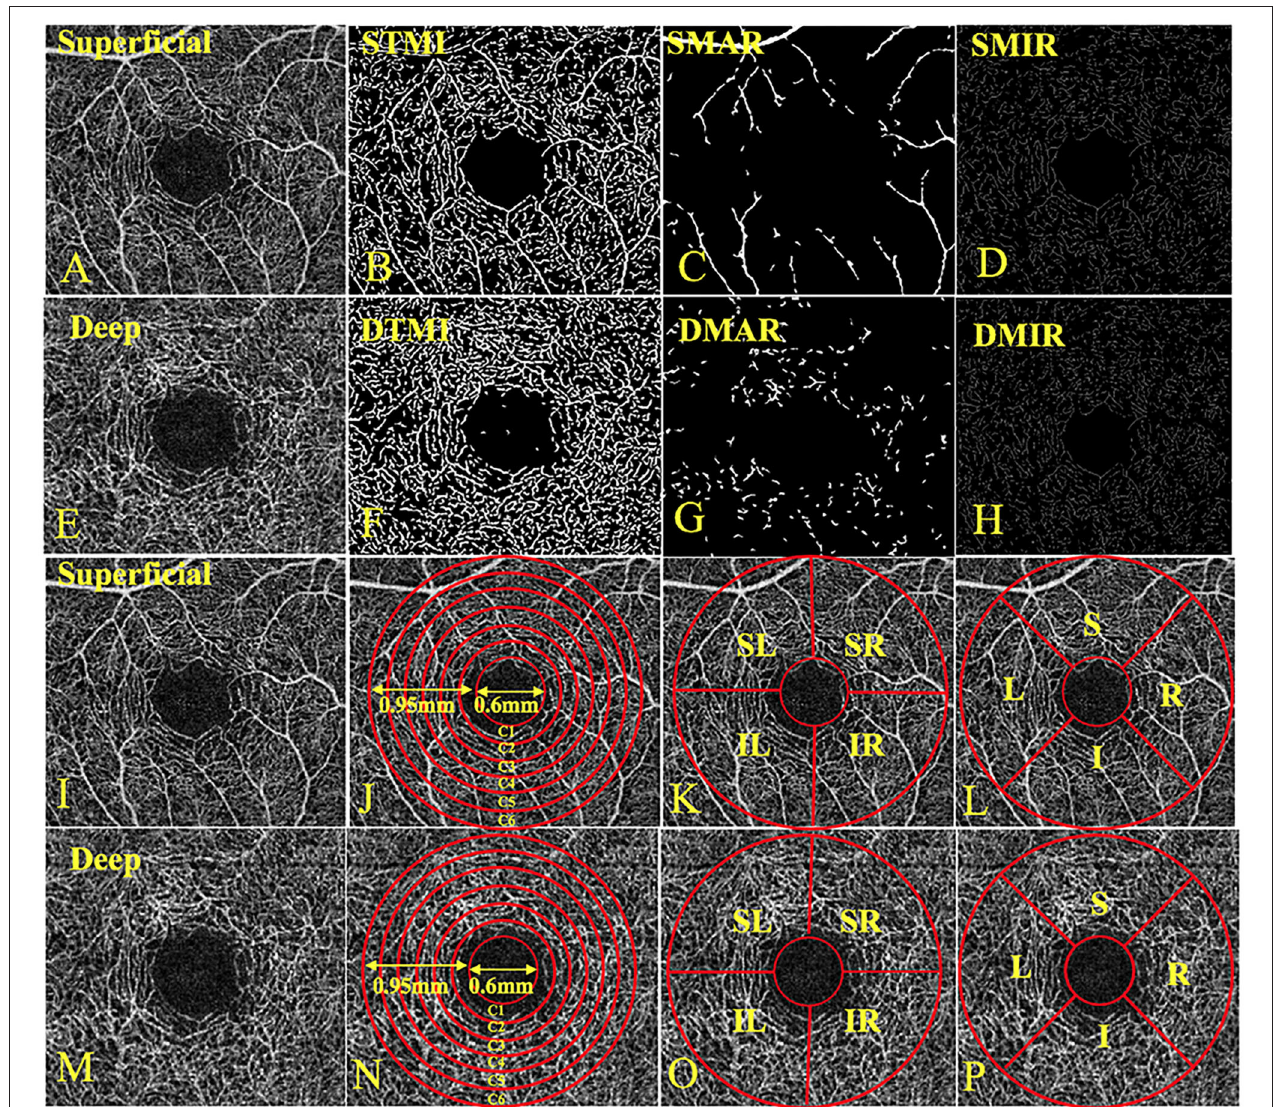
FIGURE 1 | The 3 × 3-mm OCTA image of the retina and three division methods. (A) Superficial retinal vessel density map; (B) STMI, Superficial total microvascular; (C) SMAR, Superficial macrovascular; (D) SMIR, Superficial microvascular; (E) Deep retinal vessel density map; (F) DTMI, Deeper total microvascular; (G) DMAR, Deeper macrovascular; (H) DMIR, Deep microvascular; (I) Superficial retinal vessel density map; (J) Central annuli segmentation method in superficial retina layer; (K) Hemisphere segmentation method in superficial retina layer; (L) Early treatment of diabetic retinopathy study (ETDRS) method in superficial retina layer; (M) Deep retinal vessel density map; (N) Central annuli segmentation method in deep retina layer; (O) Hemisphere segmentation method in deep retina layer; (P) Early treatment of diabetic retinopathy study (ETDRS) method in deep retina layer. L, left; R, right; S, superior; I, inferior; IL, inferior left; IR, inferior right; SL, superior left; SR, superior